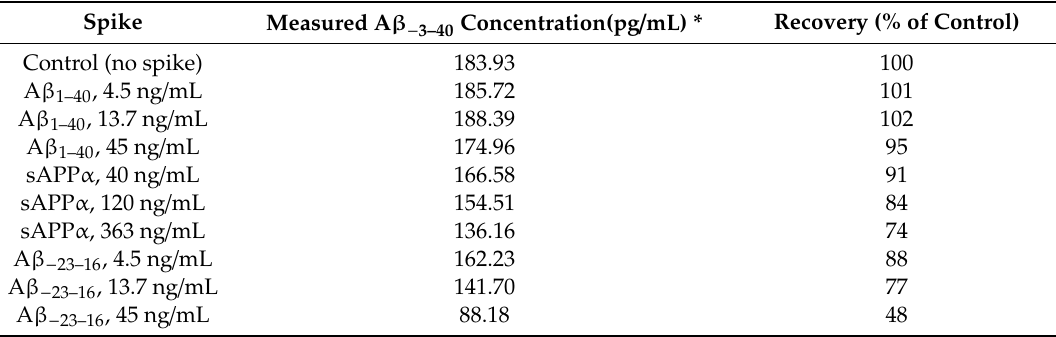
Table 4. Analysis of assay interference.